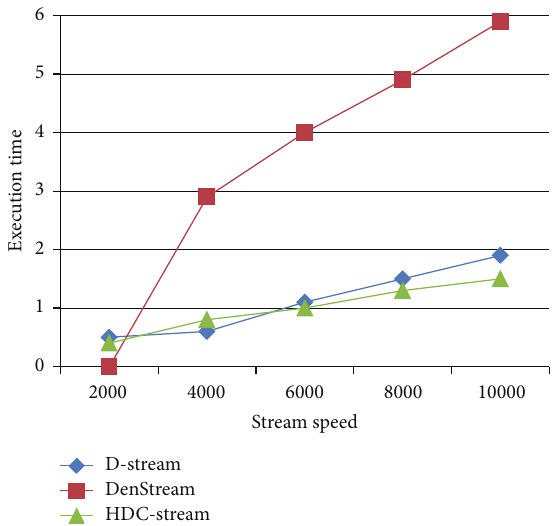
Figure 9: Execution time for increasing stream lengths on Network Intrusion Detection dataset.